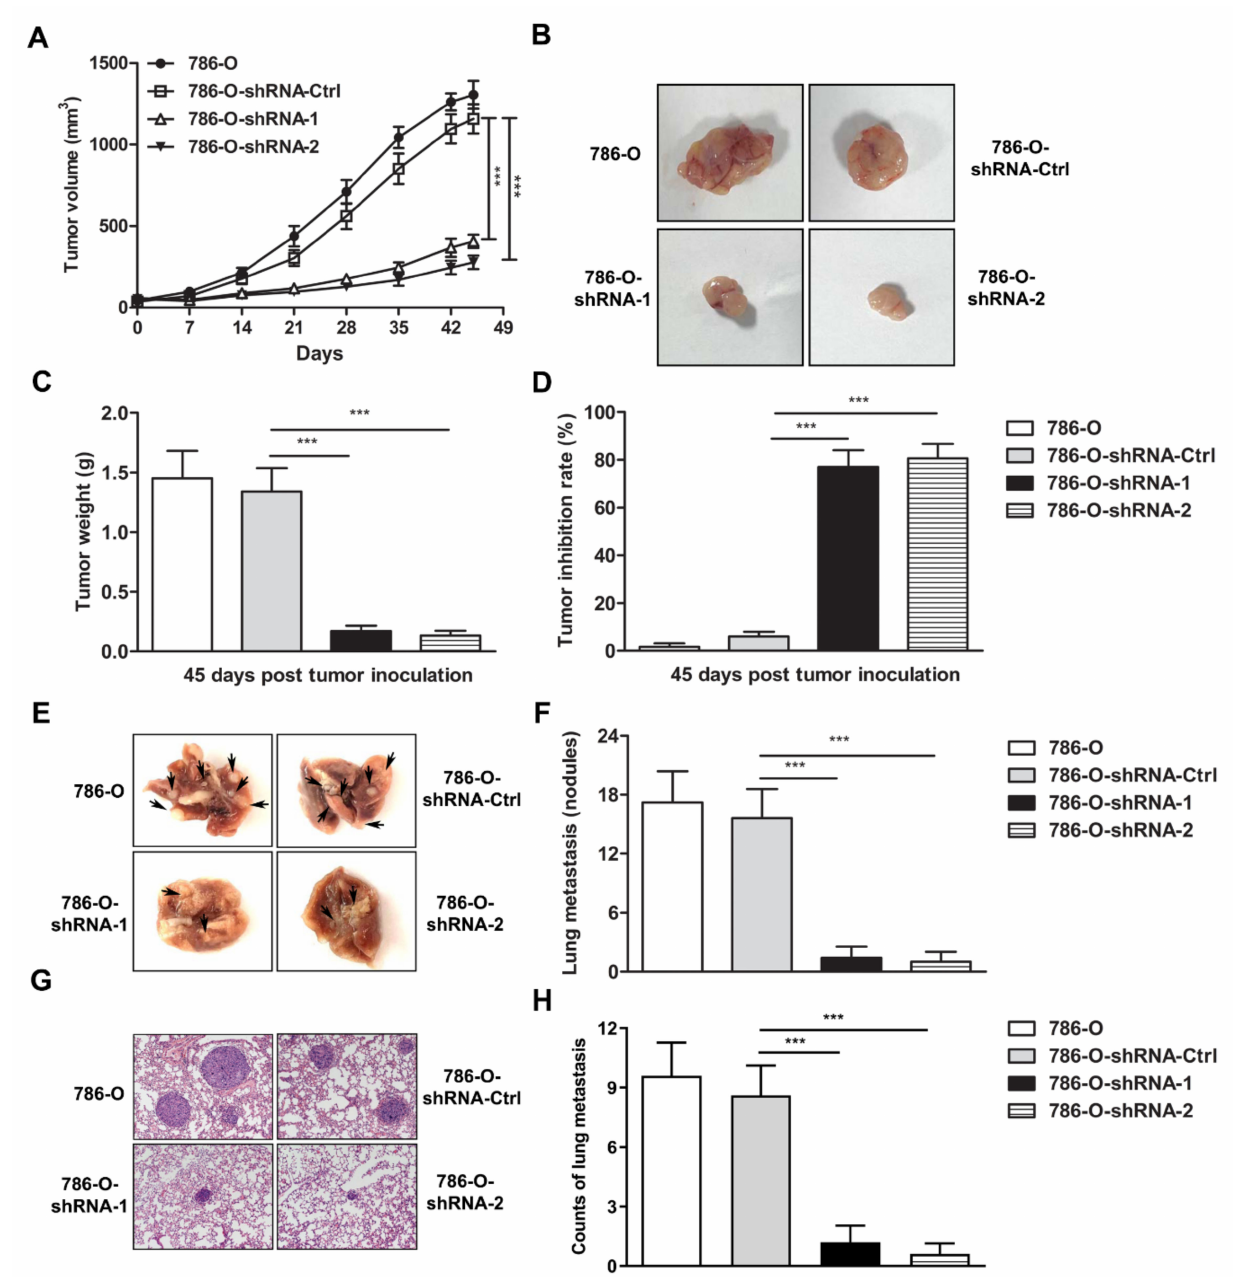
Figure 3. Inhibition of tumor growth of 786-O cell-xenografted nude mice by IFI35 knockdown. The nude mice were inoculated subcutaneously with shRNA-IFI35 or shRNA-Ctrl-treated 786-O cells. ( A ) Tumor progression of 786-O cell-xenograft was measured once every 7 days from day 0 to day 45. ( B ) Forty-five days after tumor inoculation, images of tumor excised from mice treated with shRNA or control shRNA were represented. ( C ) Tumor weight was illustrated. ( D ) Tumor inhibition rate was graphed. ( E ) The present images constituted lung tumors excised from tumor-bearing mice. ( F ) The numbers of metastatic nodules were quantified in the lung tissues. ( G ) H&E staining for lung tissues is presented ( × 200 magnification). ( H ) Lung metastasis counts were analyzed for comparisons among the four groups. The experiments were performed with five mice per group. Each experiment was performed independently at least three times and the results of one representative experiment are shown. Data are means ± SD, *** p